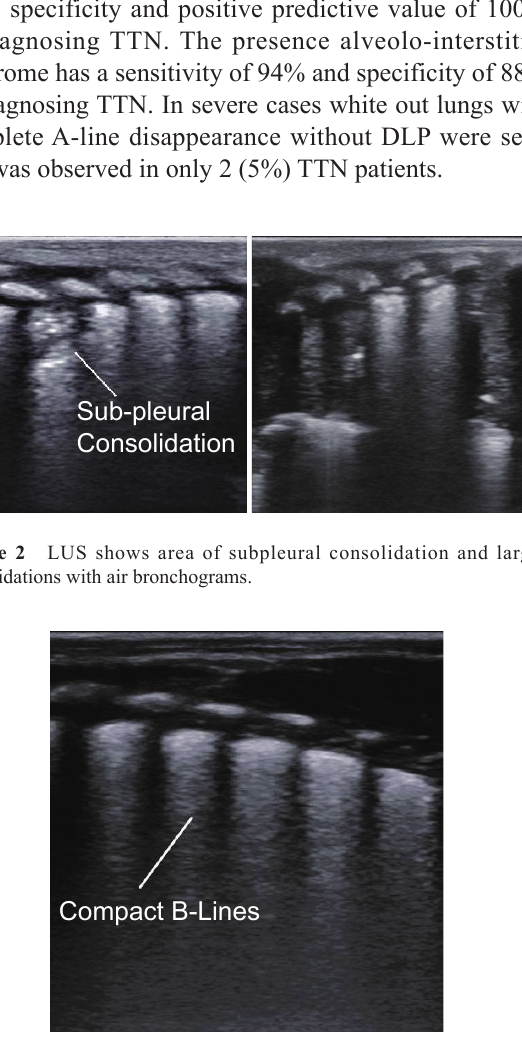
Figure 3 White out lung arising from 3-mm apart confluent B-lines and represents alveolar edema.